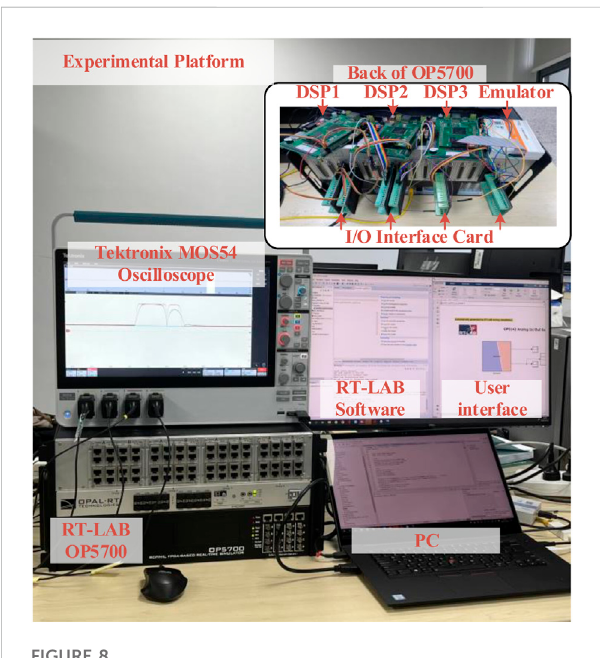
FIGURE 8 Hardware in loop experimental platform.